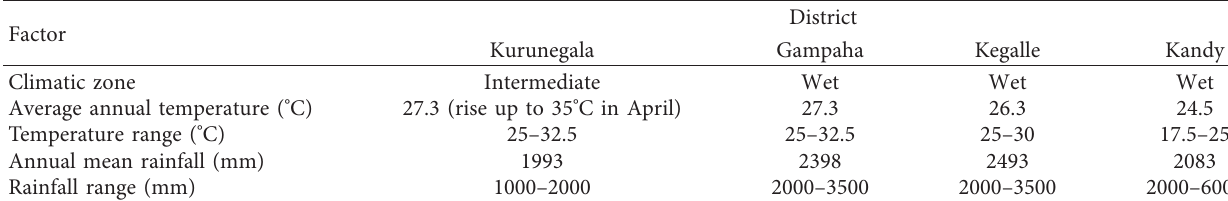
Table 1: Ecological characteristics of the study